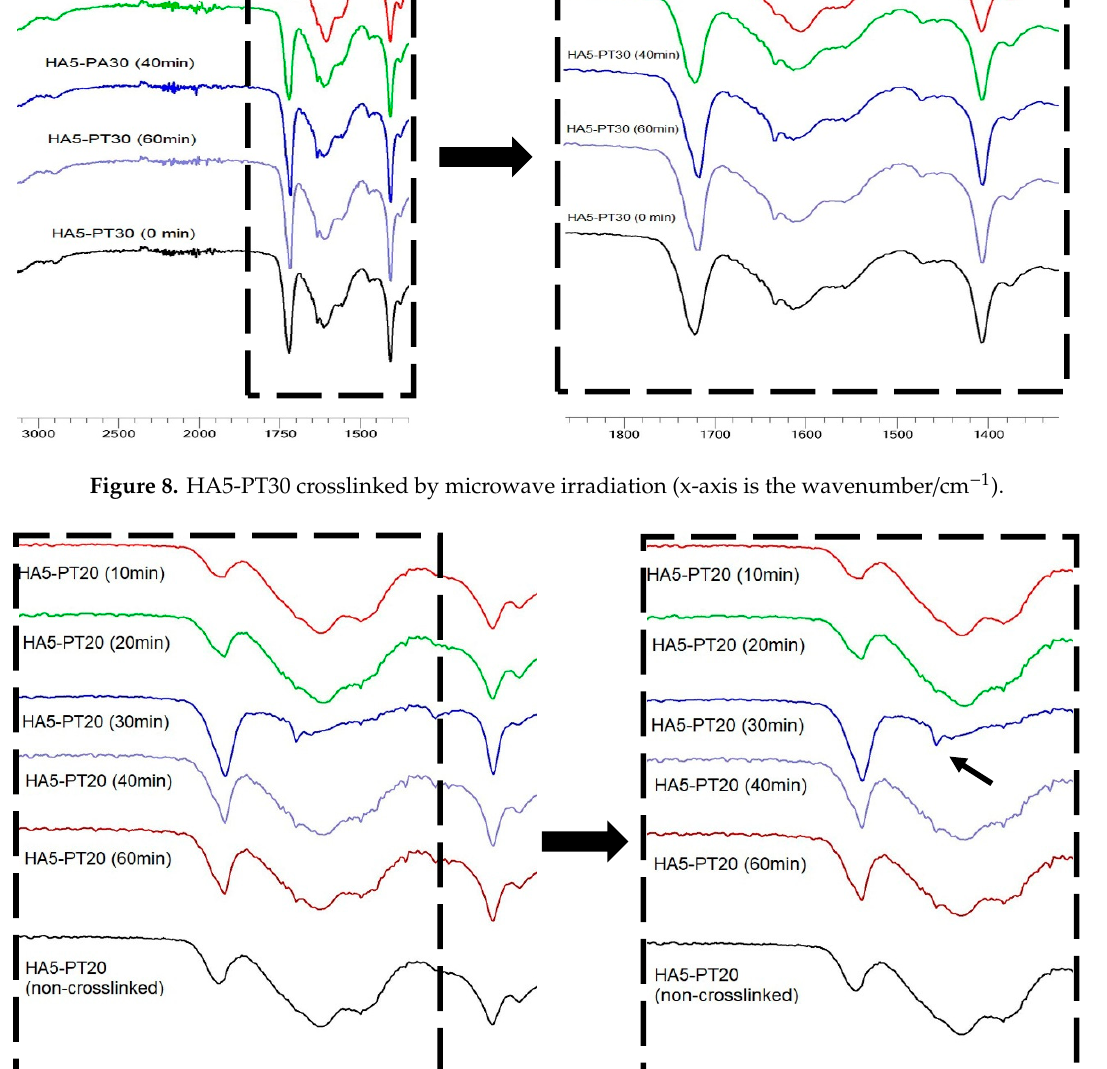
Figure 9. HA5-PT20 crosslinked by microwave irradiation (x-axis is the wavenumber / cm − 1 ). At 30 min, the C = C in the acrylate group, which is around 1,640 cm − 1 was preserved.